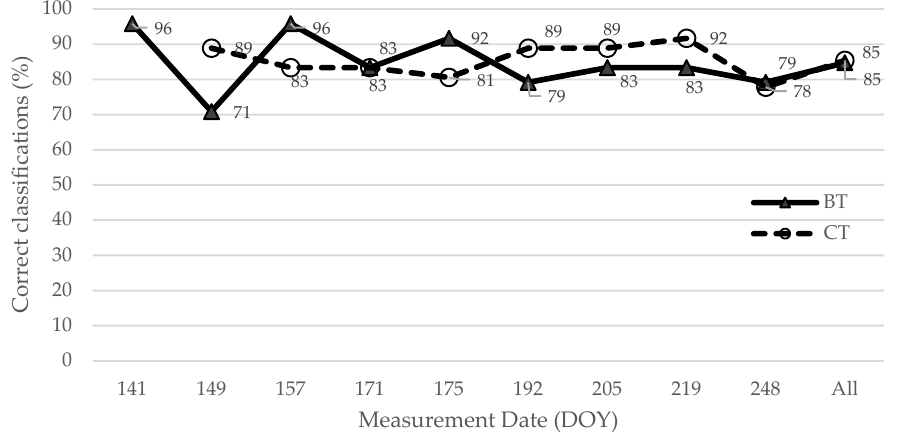
Figure 3. Percentage of correct classification predictions as ‘asymptomatic’ by date and test site using the SFVS strategy, followed by an SVM algorithm with radial kernel and class weights (stepsvmrw model). Values of BT site are represented with triangles and CT with circles. DOY—Day of the year.